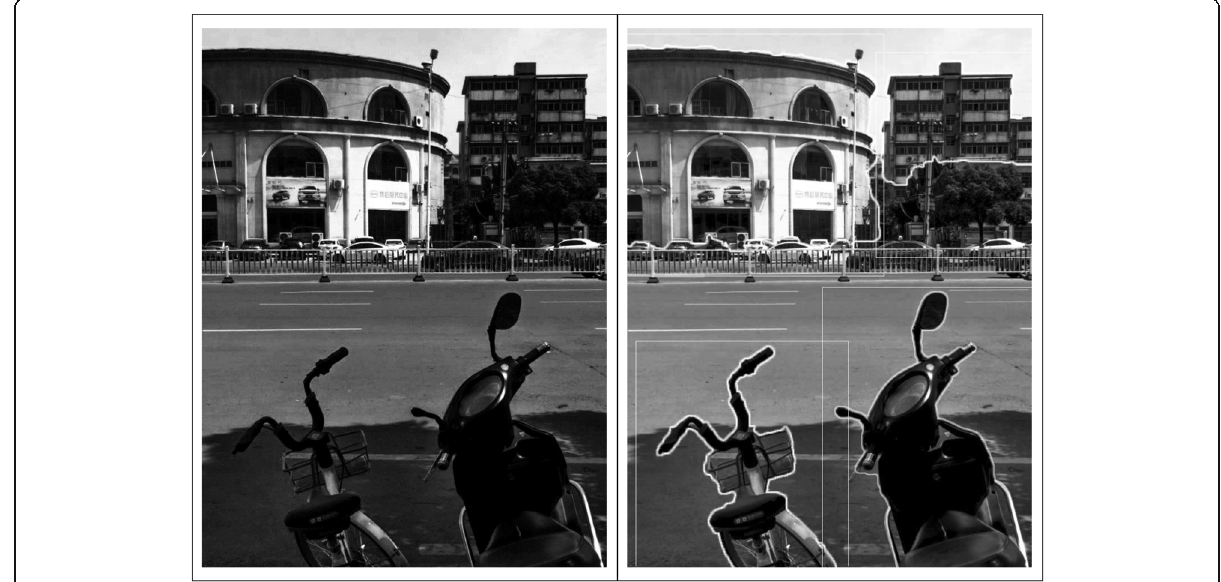
Fig. 6 Analogy before and after splitting (left is the original image, right is the split